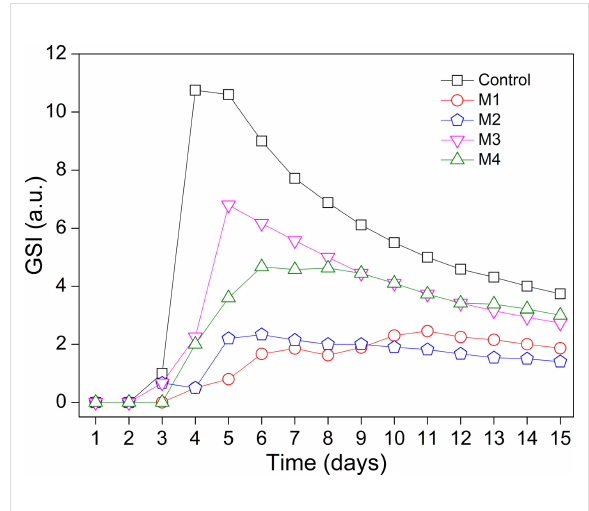
Figure 6: GSI in bean seeds covered with: Control, M1 = neat alginate, M2 = alginate + ZnAl-CO 3 -LDH, M3 = alginate + NAA and M4 = alginate +